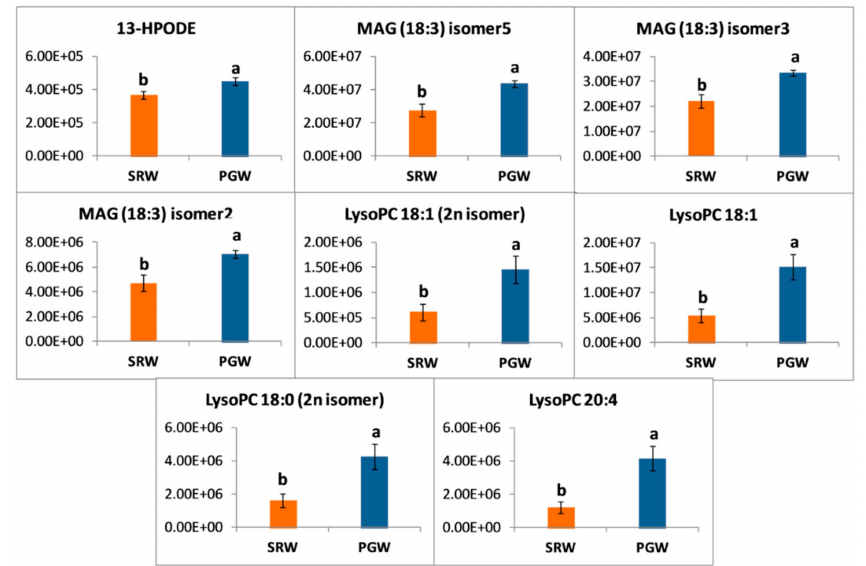
Figure 9. Y -axis shows the differences in relative contents of lipids between pumpkin-grafted watermelon (PGW) and self-rooted watermelon (SRW). Vertical bars represent standard error among three independent replicates. Data are the mean ± SE of three replicates. Different lowercase letters indicate significant differences at p <